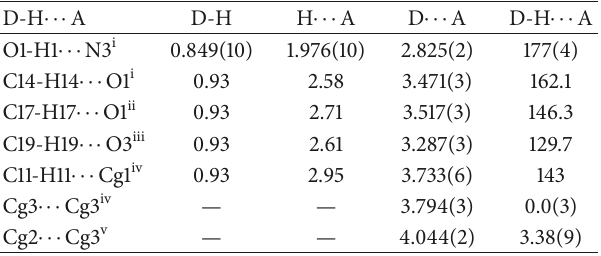
Table 2: Hydrogen-bond and C-H ⋅⋅⋅𝜋 geometry (˚A and ∘ ) of title compound a .